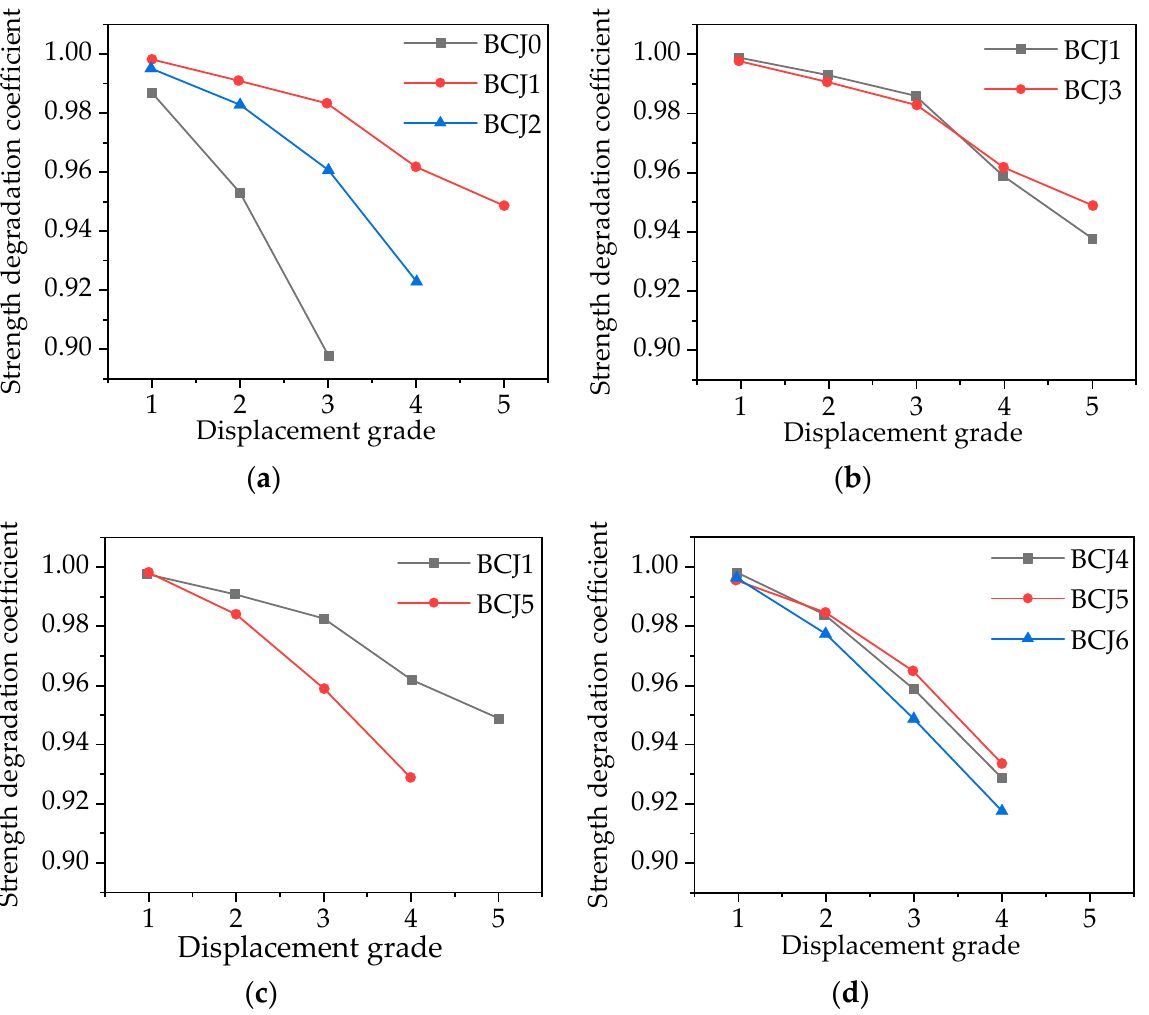
Figure 16. Relationship between strength degradation coefficient and the displacement grade with: ( a ) Different volume ratios of steel fiber; ( b ) Different concrete strength; ( c ) Different stirrup ratios; ( d ) Different axial compression ratios.